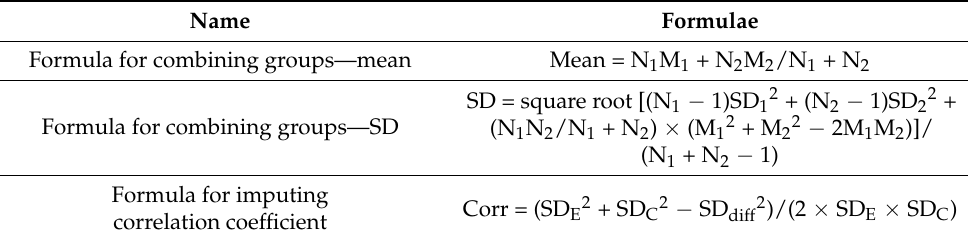
Table 1. Formulae used for data extraction for continuous